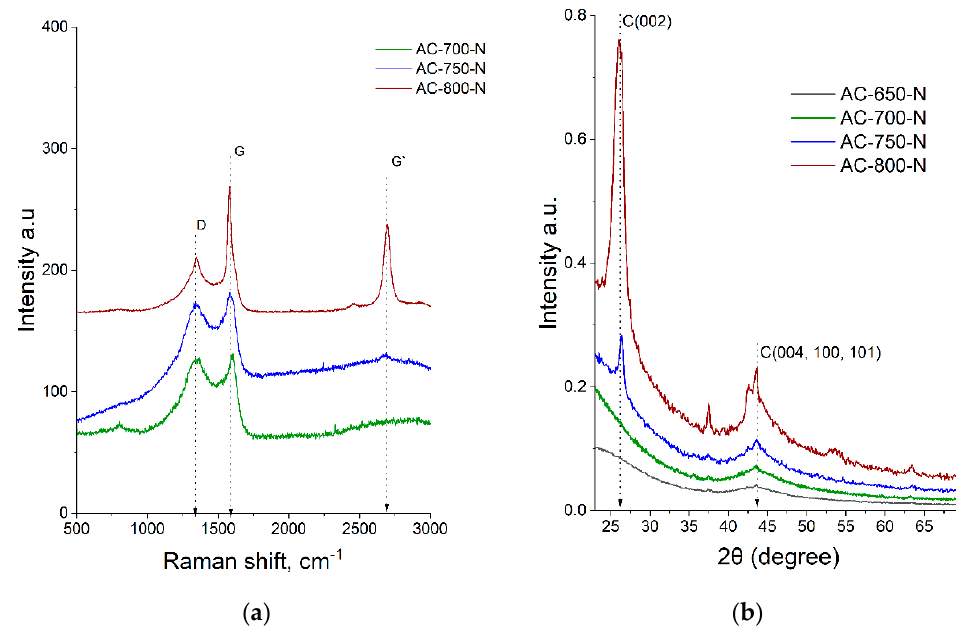
Figure 3. Raman spectra of wood-based, nitrogen-doped activated carbons synthesized at various temperatures ( a ); X-ray diffraction spectra of wood-based, nitrogen-doped activated carbons synthesized at various temperatures ( b ).